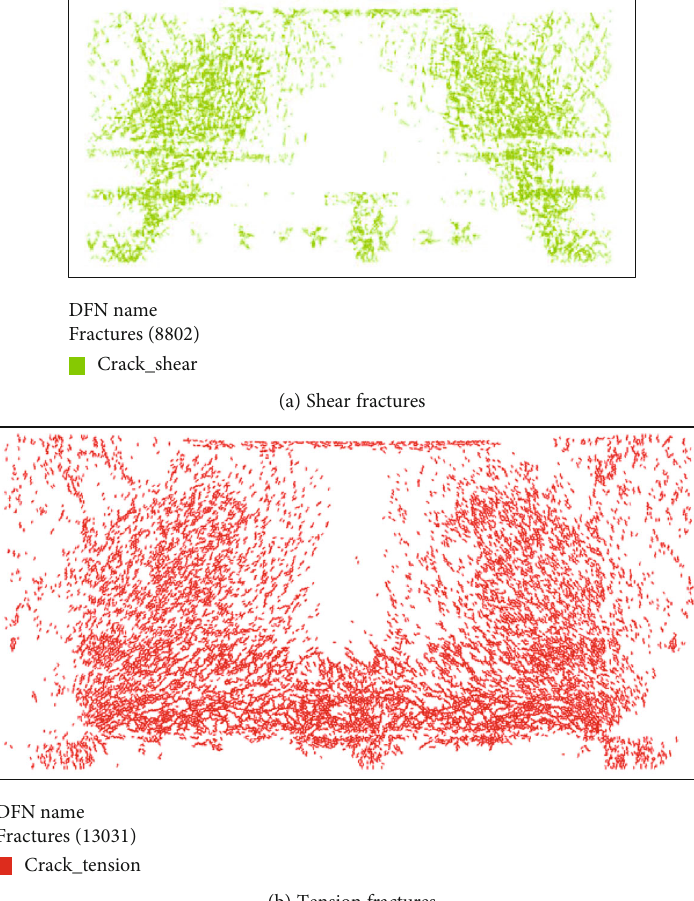
Figure 12: Distribution of fractures in numerical